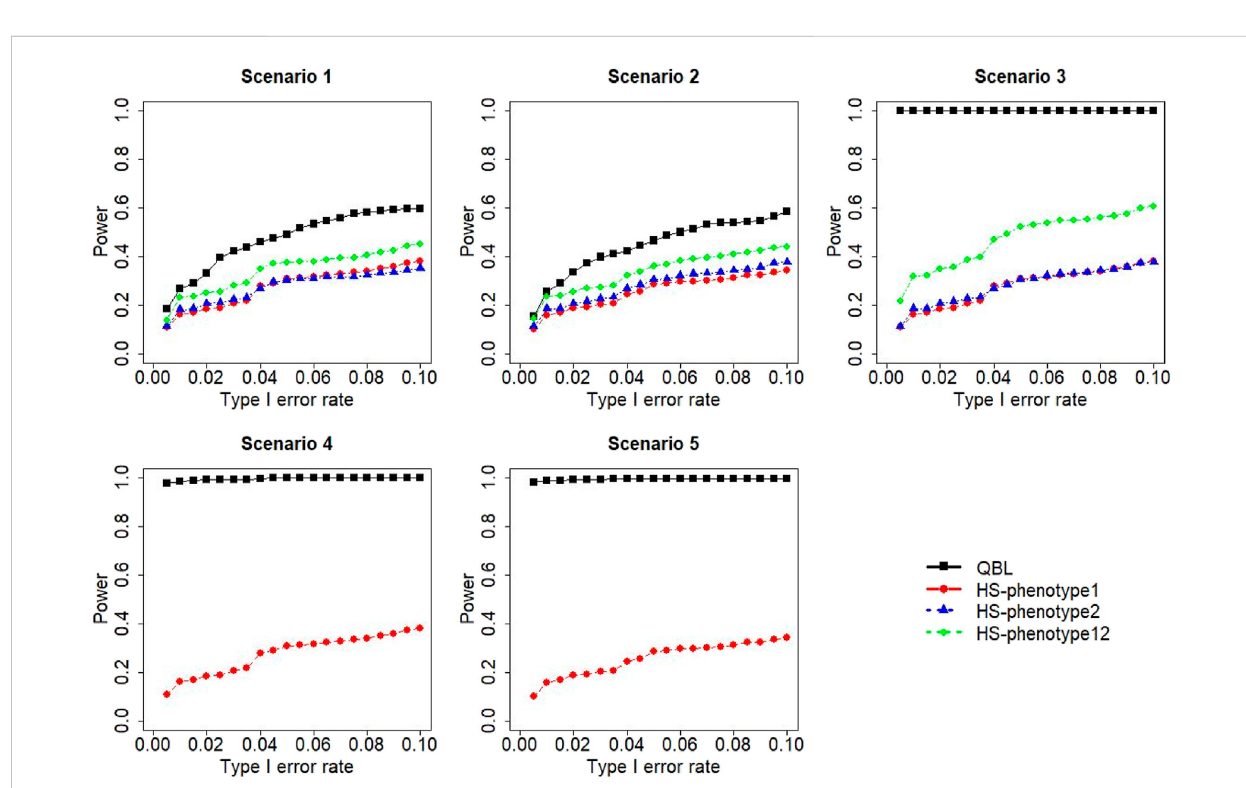
FIGURE 9 Simulation results under sample size 500, setting 2 (12 haplotypes), and ρ = 0.9. Scenarios are shown in Table 1. HS, Haplo.score; phenotype12, phenotype 1 or